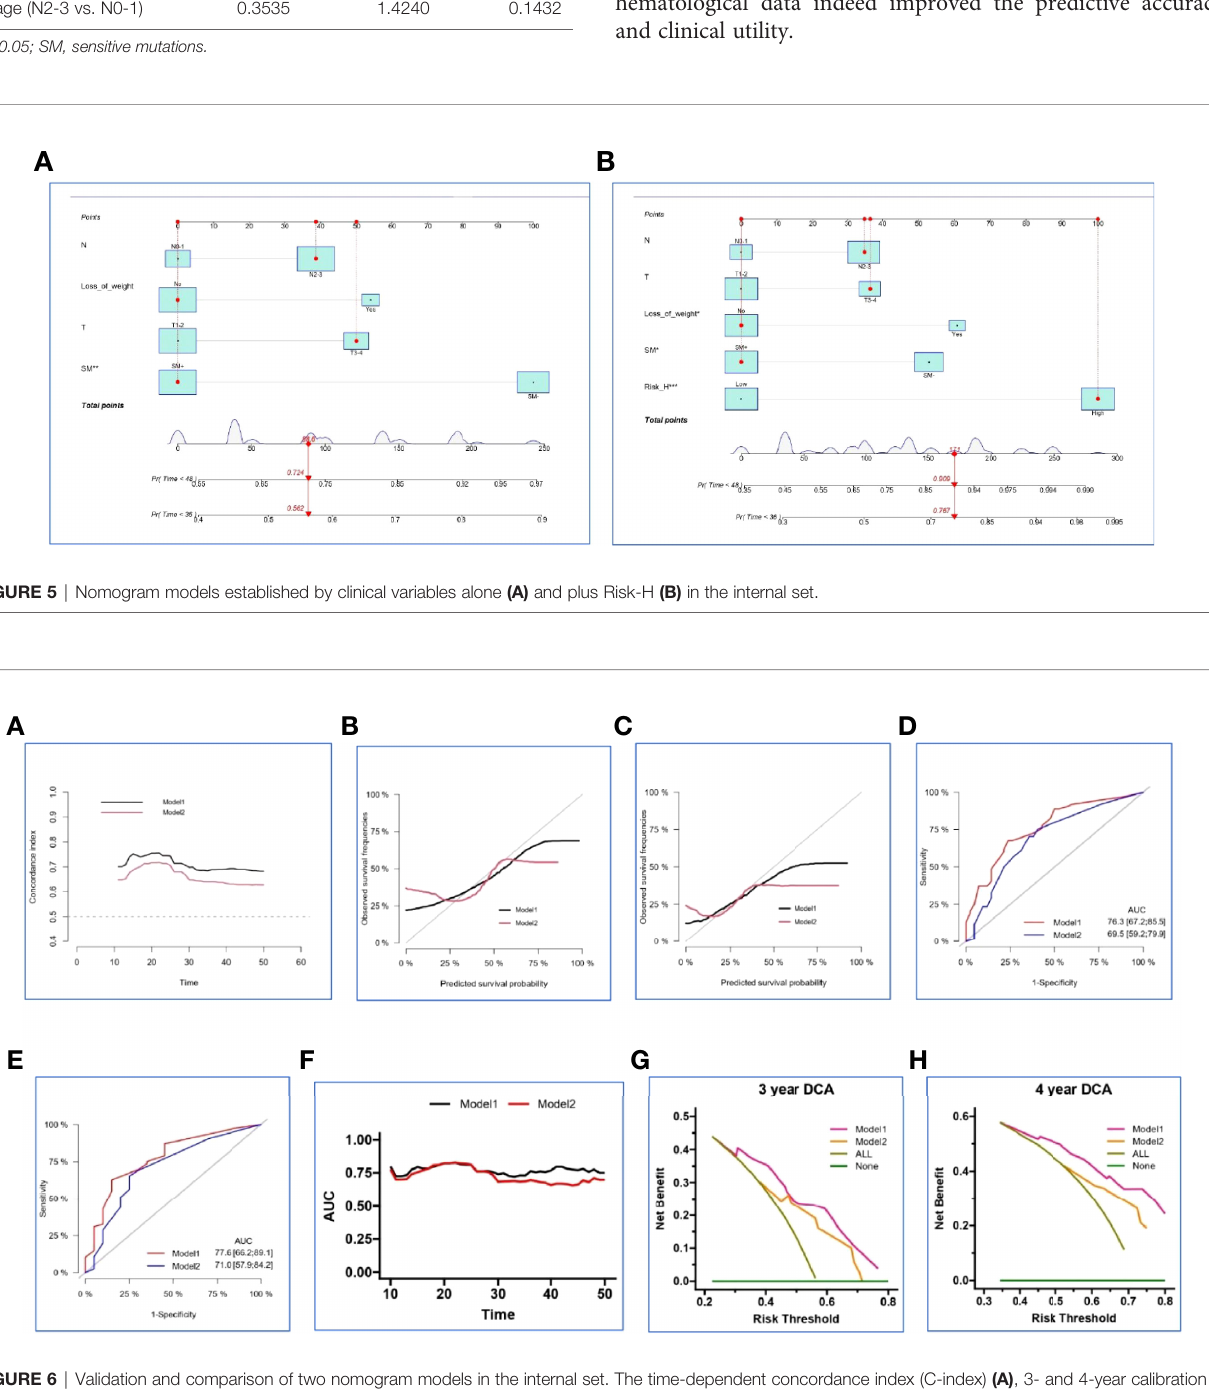
FIGURE 6 | Validation and comparison of two nomogram models in the internal set. The time-dependent concordance index (C-index) (A) , 3- and 4-year calibration curves (B, C) , 3- and 4-year ROC analysis (D, E) , time-dependent area under the curve (AUC) (F) , 3- and 4-year decision curve analysis (DCA) (G, H) basing on Model 1 and Model 2.